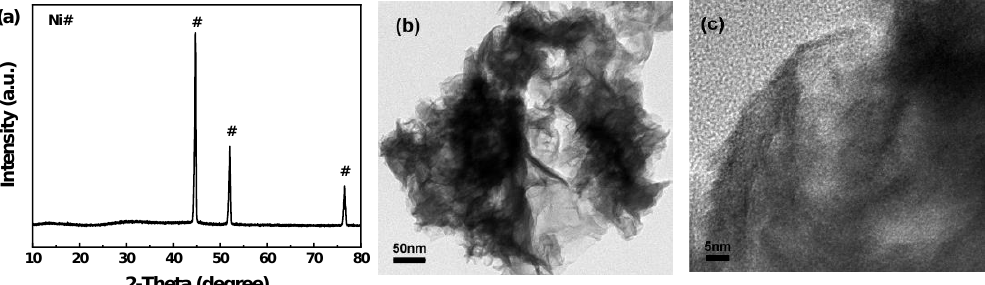
Figure 2. ( a ) XRD pattern of CoSe/Co 3 O 4 -CNTs/NF, ( b , c ) TEM images of CoSe stripped from the substrate.